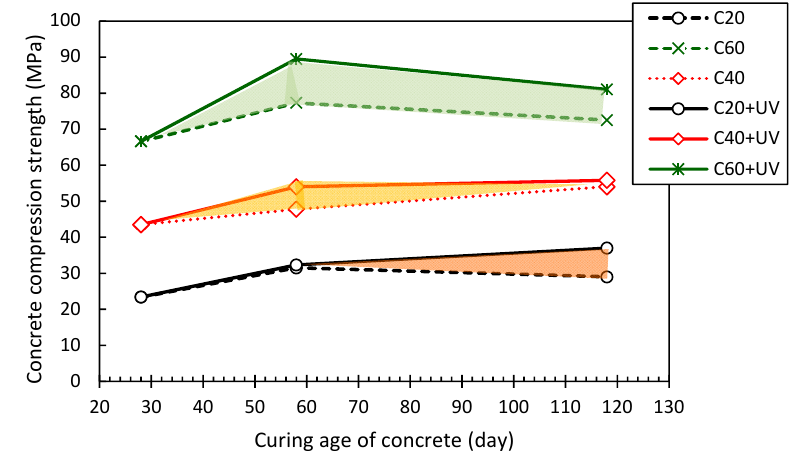
Figure 14. Effect of UV exposure on concrete compressive strength.